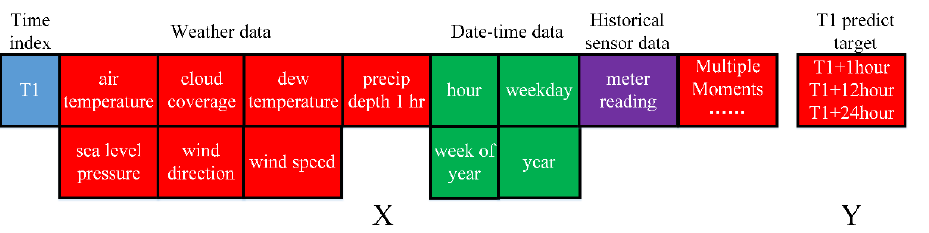
Figure 2. Detailed construction of a single